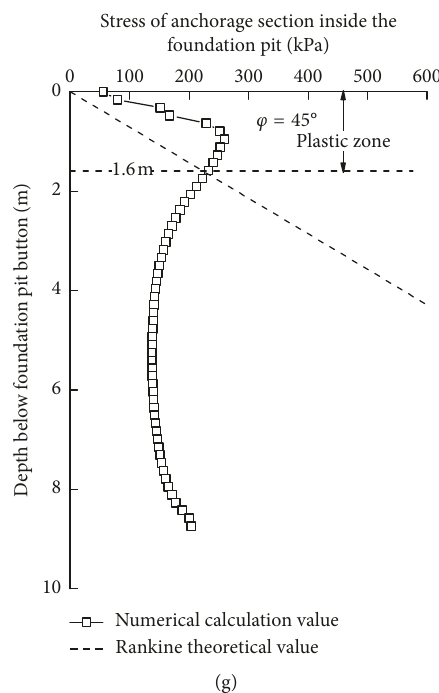
Figure 10: Range of the plastic zone at different internal friction angles φ : (a) φ � 15 ° , (b) φ � 20 ° , (c) φ � 25 ° , (d) φ � 30 ° , (e) φ � 35 ° , (f) φ � 40 ° , and (g) φ � 45 °